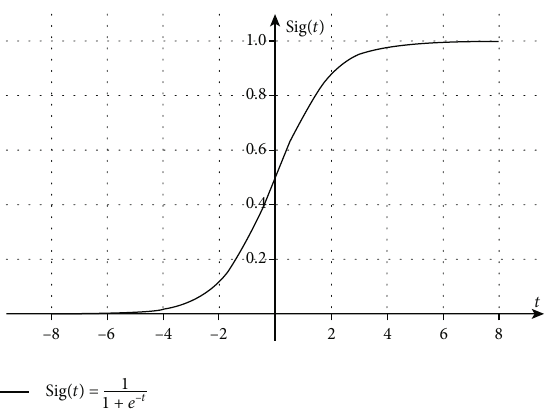
Figure 13: Sigmoid function behavior at a discrete event time scale length.